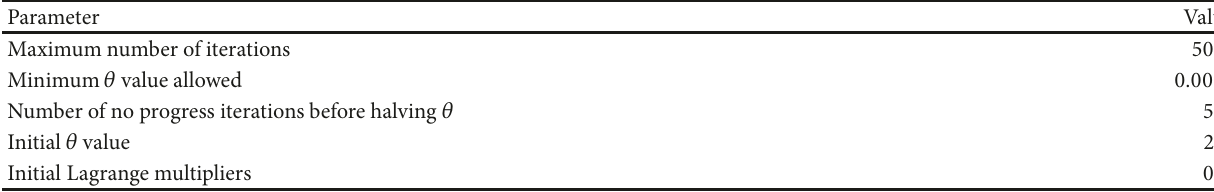
Table 2: Parameters for Lagrangian procedures.